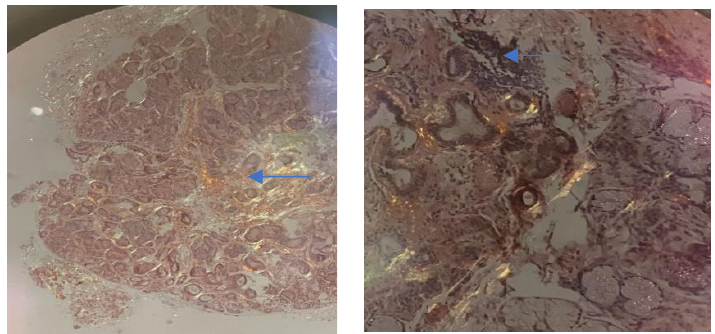
Figure 2. Amyloid deposits on a lip biopsy using Congo red staining. Blue arrow shows the amyloid deposits.